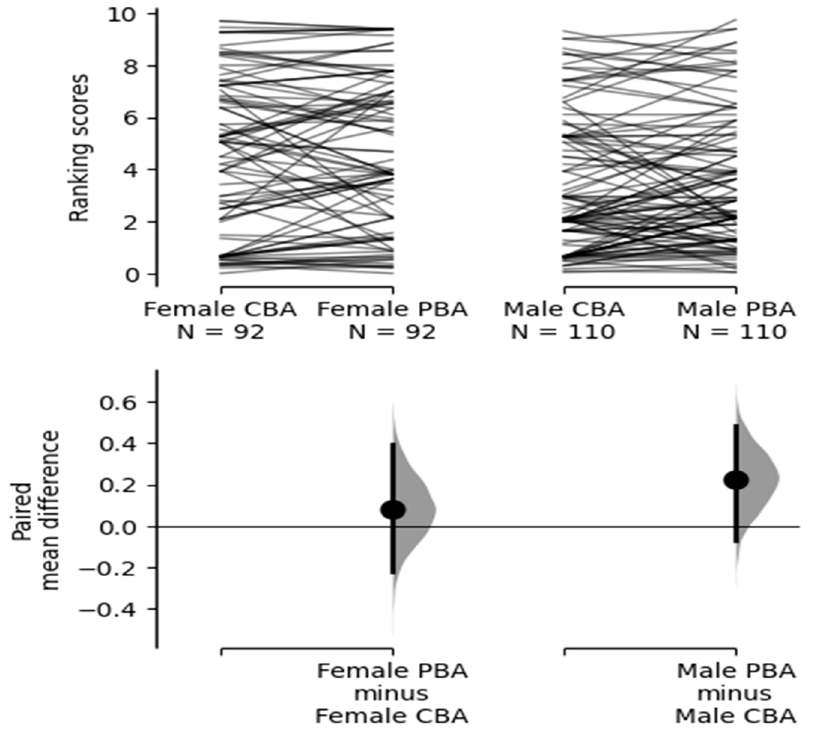
Figure 5. Gardner–Altman estimation plot for the paired mean difference between PBA and CBA rank scores in science subjects of 92 females and of 110 males.